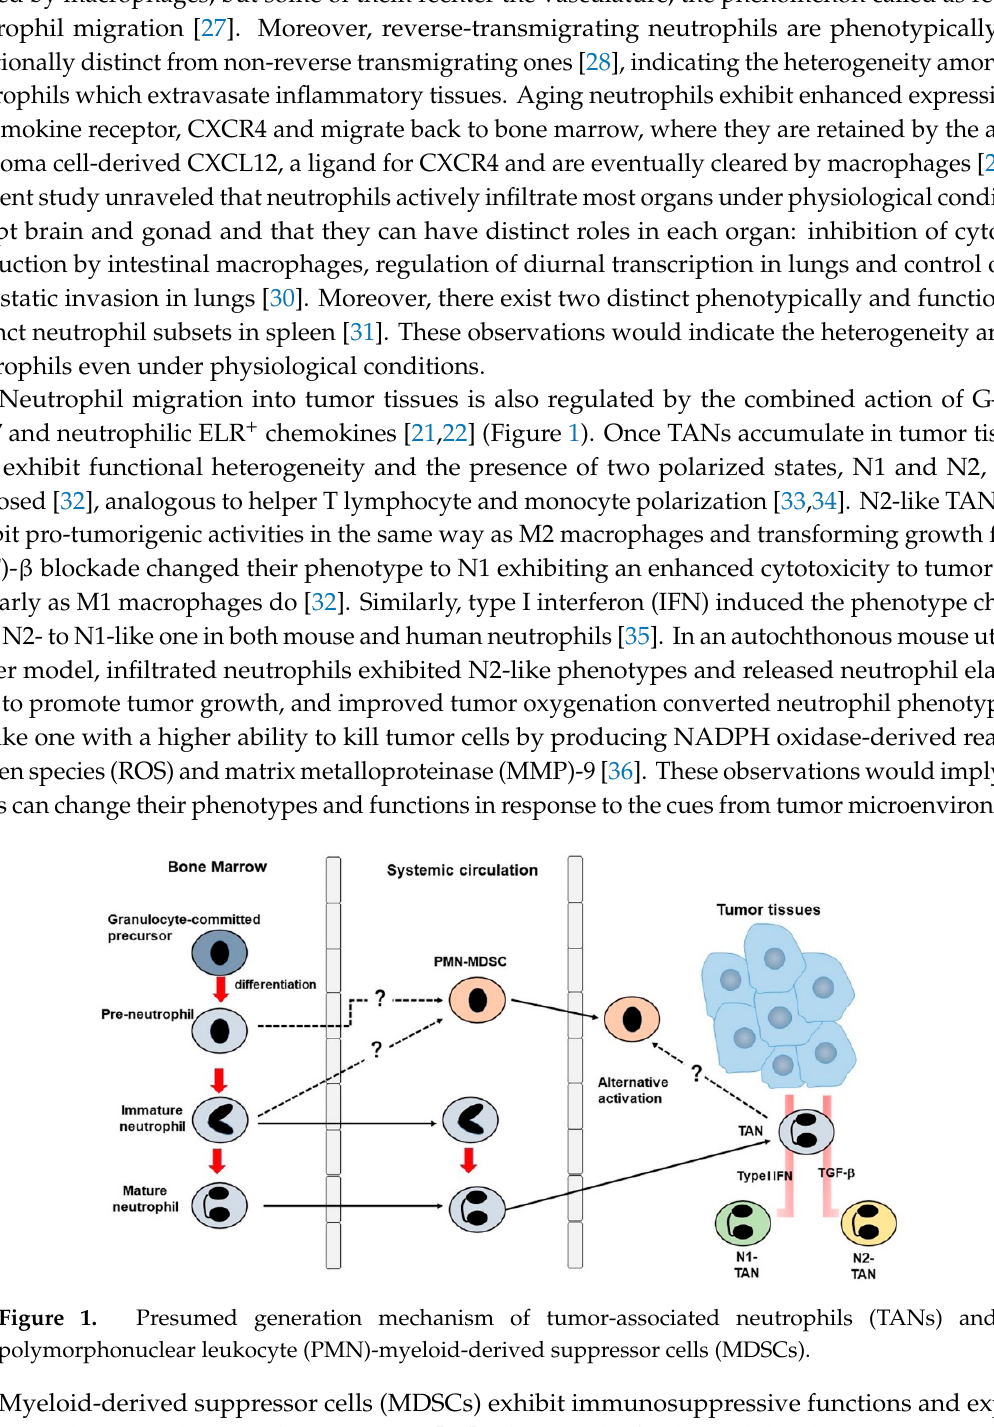
Table 1. Surface markers of mouse and human preneutrophils, immature neutrophils and mature neutrophils. Lin, lineage